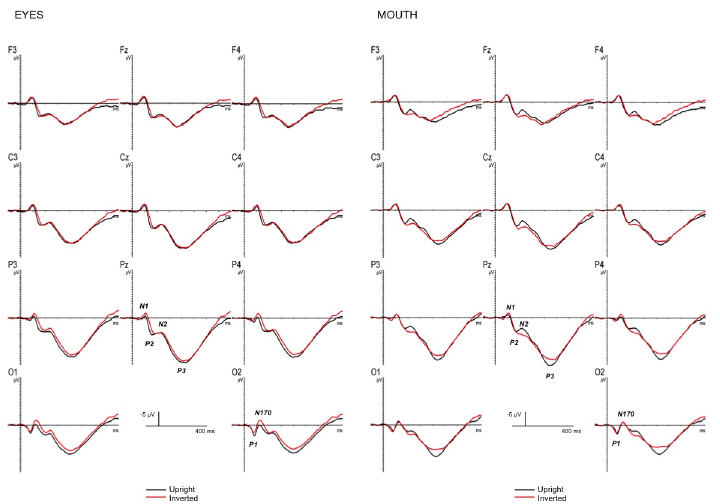
Fig 2. ERP effects of face orientation. Grand-averaged event-related potentials to target faces as a function of internal features and face orientation.